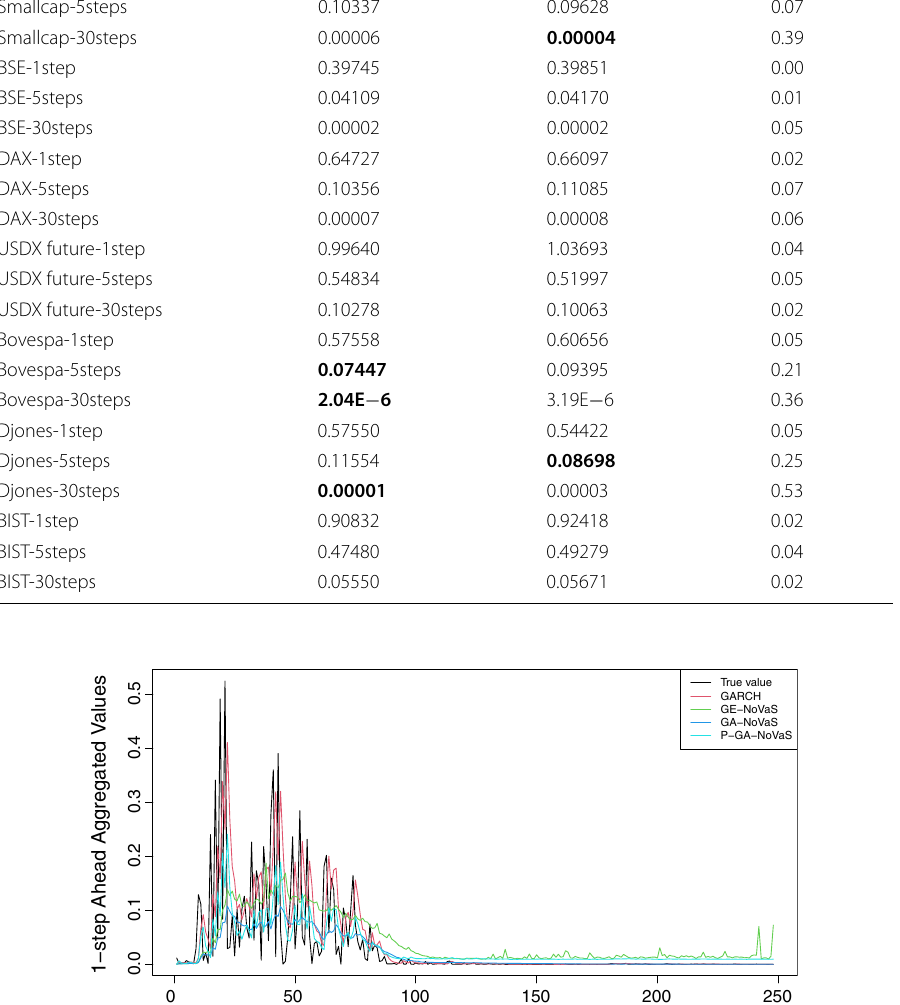
Model 6 which is an Exponential GARCH(1,1) (EXP-GARCH(1,1)) model. We also esti- mate an Exponential GARCH(1,1) model to do predictions and set it as the benchmark. The comparison of different methods is tabulated in Table 12. The results show the P-GA-NoVaS method is the best one for all three prediction horizons, which highlights the superior ability of NoVaS methods on forecasting short data.